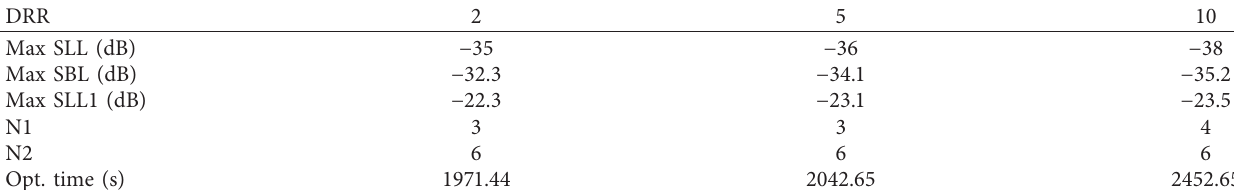
Table 3: Comparison of optimization results under different DRR